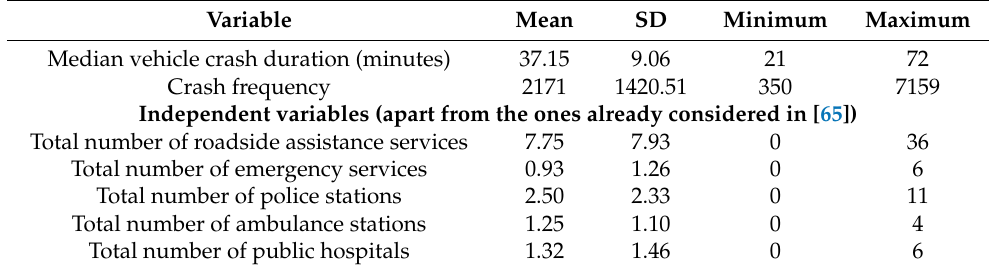
Table 1. Descriptive statistics of the